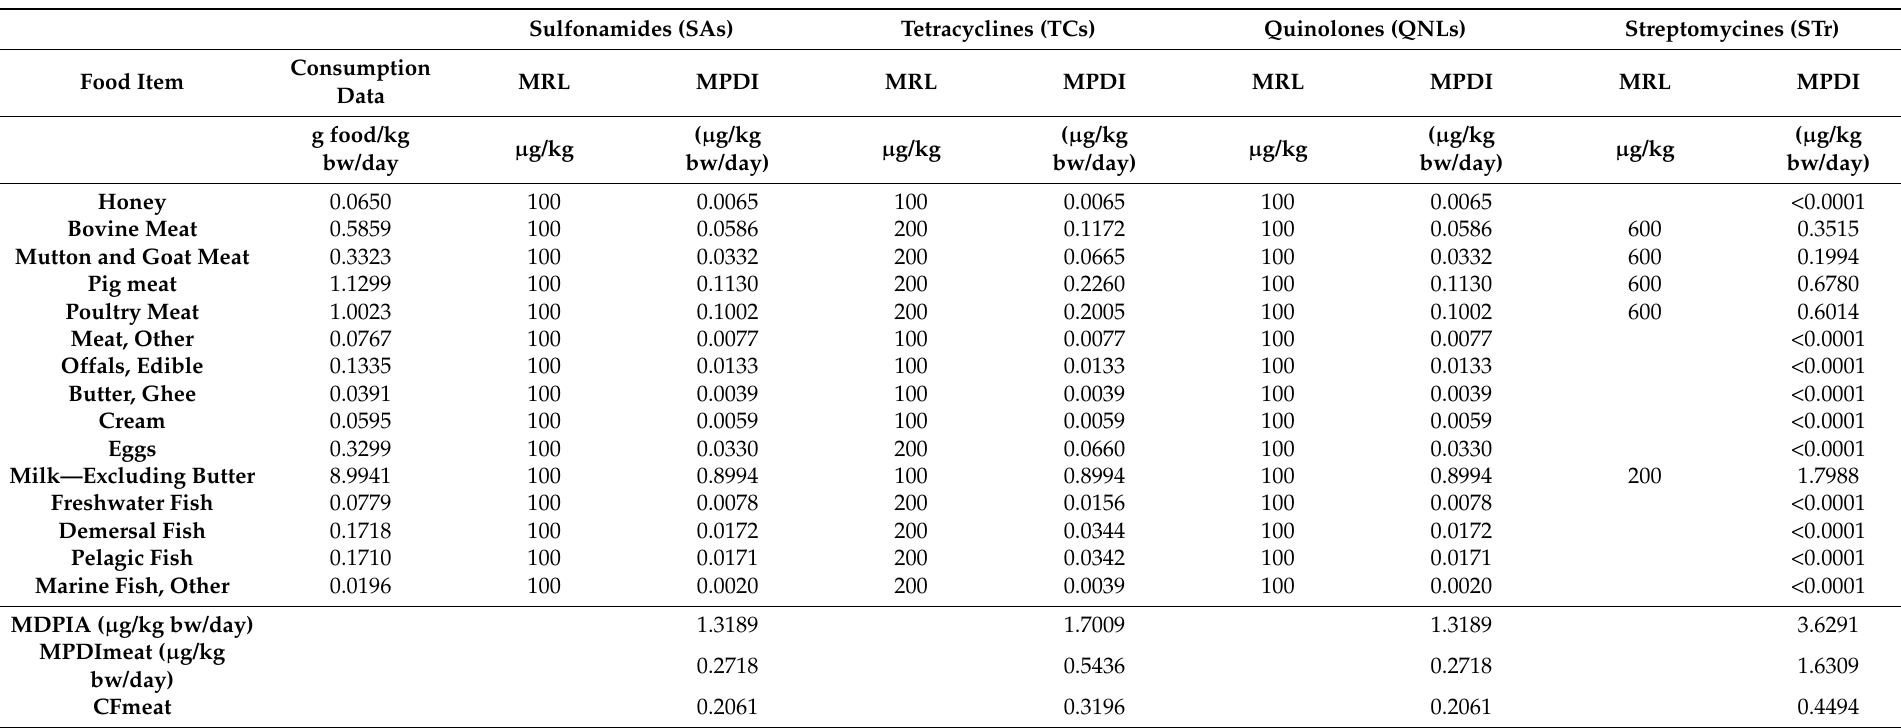
Table 1. Consumption data of food items contributing to the antibiotic dietary exposure, the respective MRLs and the calculated maximum “permitted” daily exposure for each food item (MPDI), for all food items (aggregated (MPDIA)), for meat items estimated (bovine, pig meat and poultry meat) (MPDIm) and correction factor calculated